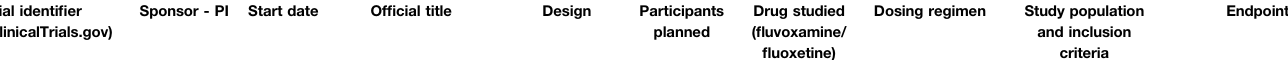
TABLE 1 | ( Continued ) Main features of completed, ongoing, suspended and withdrawn trial on fl uvoxamine and fl uoxetine in patients with